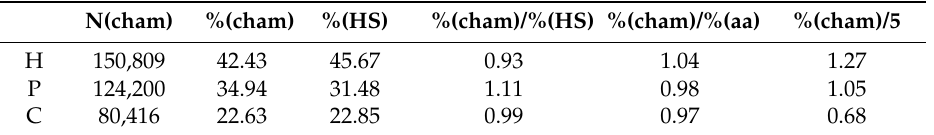
Table 5. Chameleon propensities of hydrophobic (H), polar (P), and charged (C) residues. N(cham) %(cham)